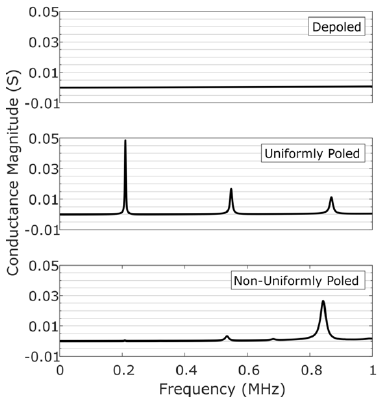
Figure 2. Magnitude of the conductance spectrum of the depoled, uniformly-poled, and non-uniformly poled piezoelectric wafers.